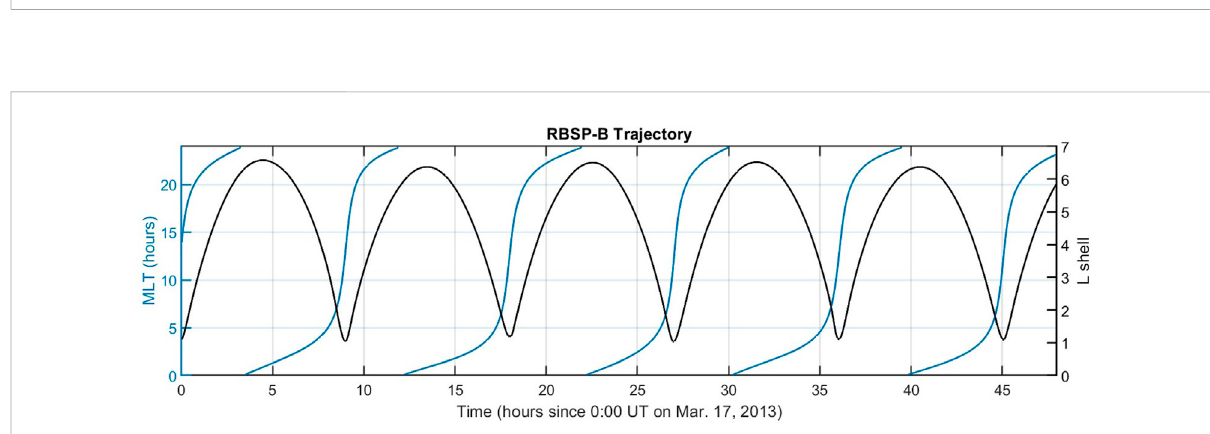
FIGURE 11 The MLT (blue) and L-shell (black) dependence of RBSP-B during the 17 March 2013